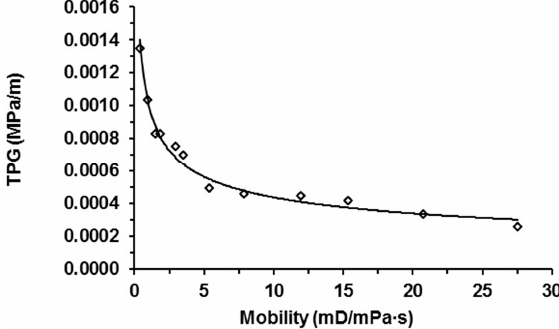
Figure 8. A power-law relationship between the TPG and mobility of heavy oil.